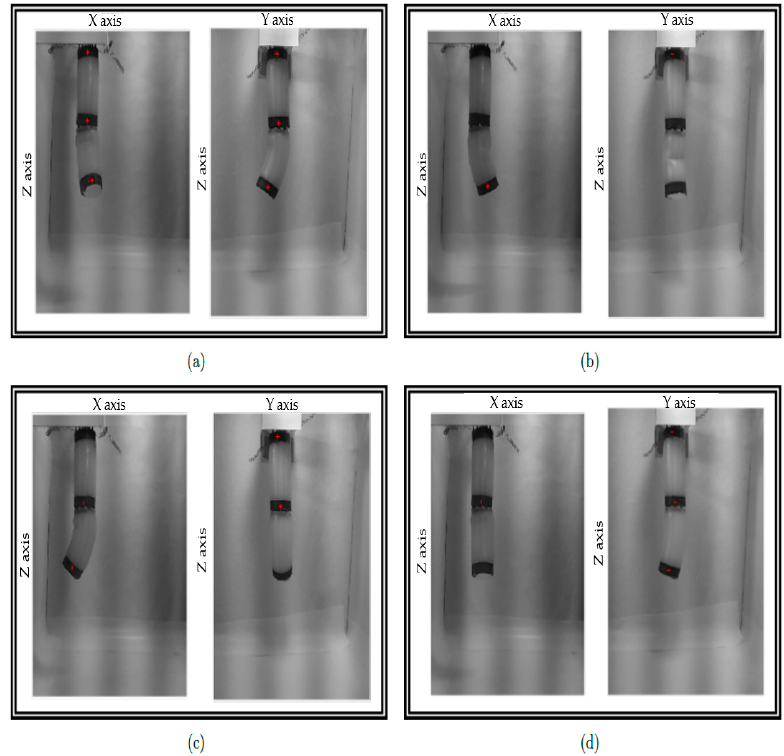
Figure 9. Experiments. The four pictures ( a – d ) show different positions reached by the soft robot. Source: authors.